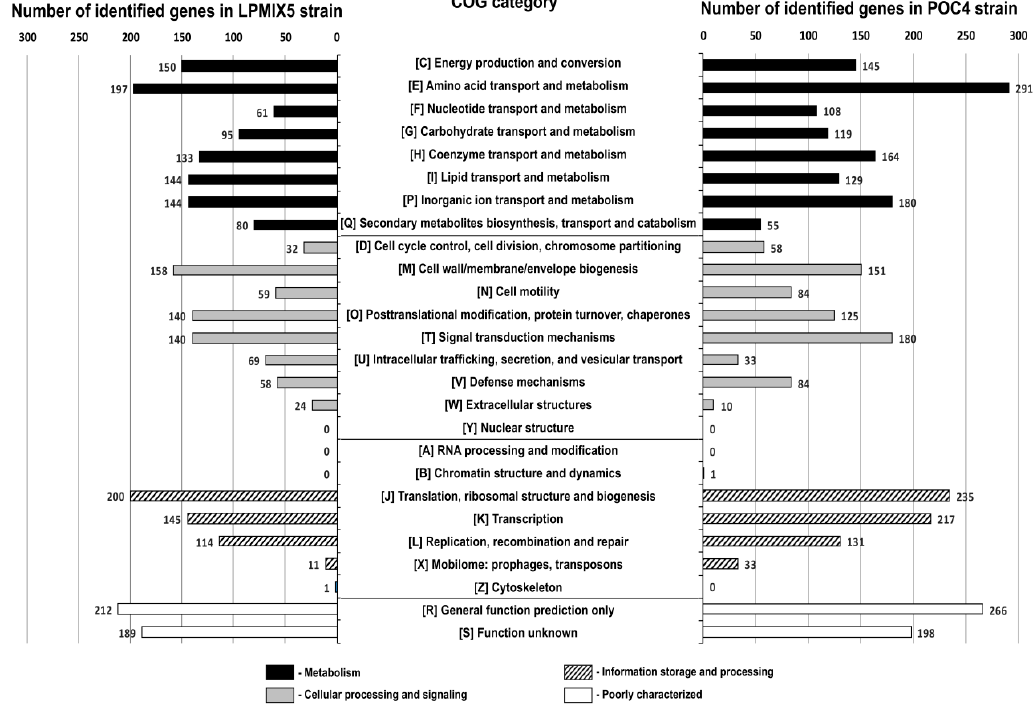
Figure 1. Number of genes of the LPMIX5 and POC4 strains classified into particular COG functional categories.